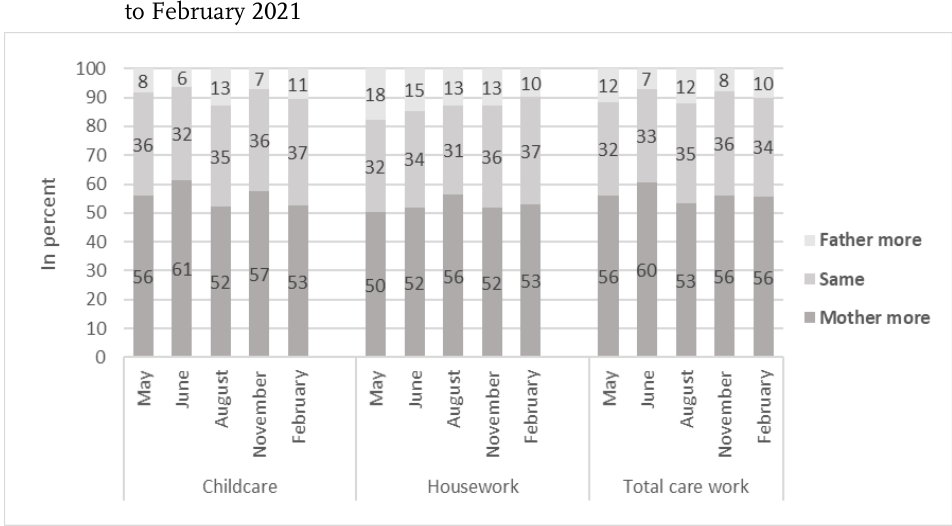
Figure 2 : Distribution of childcare, housework, and total care work in couples, May 2020 to February